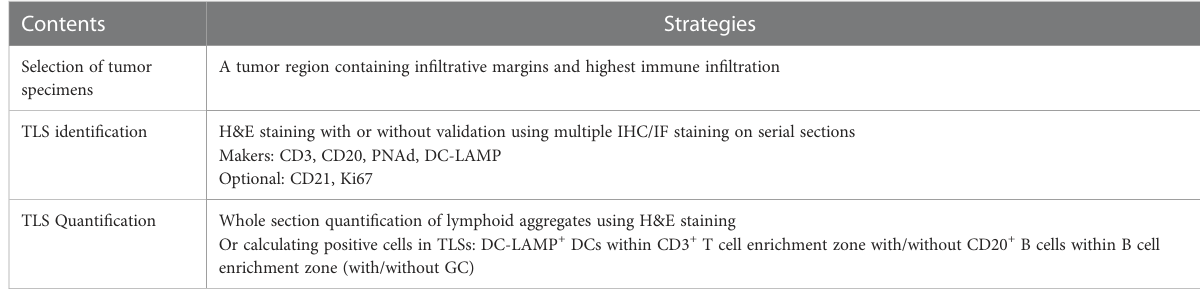
TABLE 4 Strategies for TLS detection in tumor